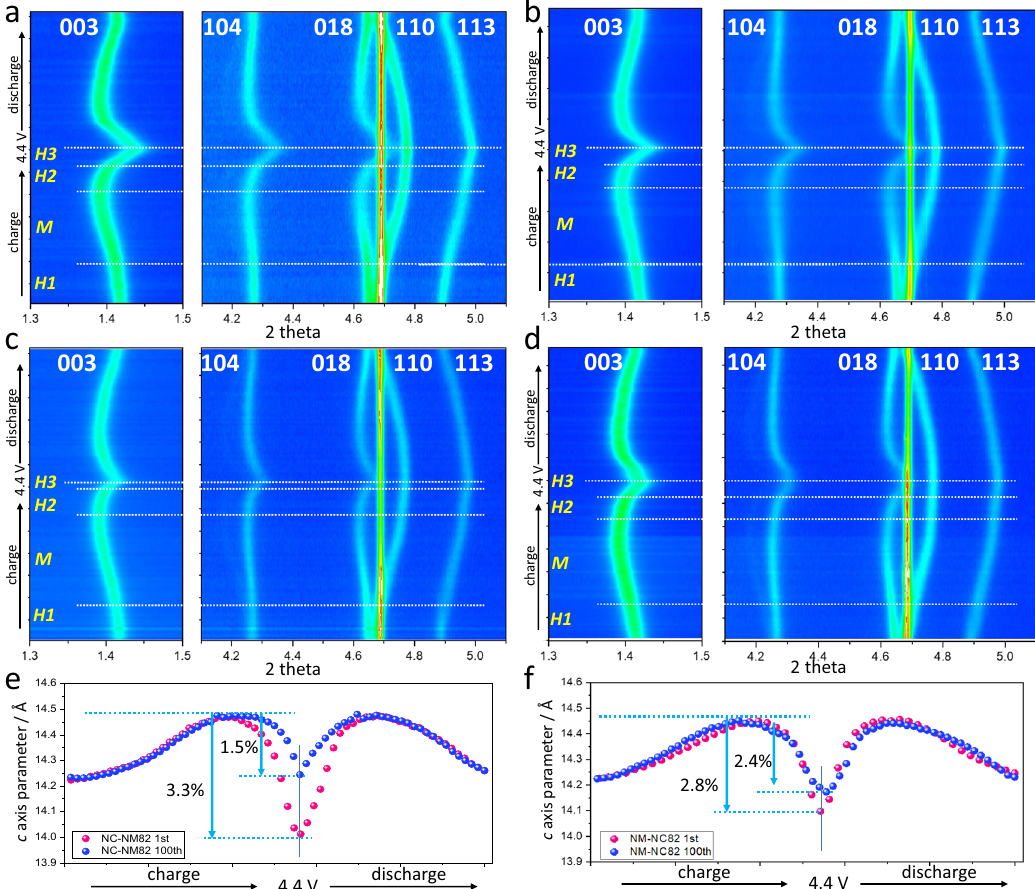
Fig. 5 In situ synchrotron HEXRD characterization during the fi rst cycle and the 101th cycle. a , b Two-dimensional (2D) contour plots of in situ XRD for the structural evolution of NC-NM82 and NM-NC82 during the initial cycle. c , d 2D contour plots of in situ XRD for the structural evolution of NC-NM82 and NM-NC82 during the 101th cycle. These cells were cycled in the voltage range of 2.8 – 4.4 V using a current rate of C/10 (1C = 200 mA g − 1 ). e The c - axis lattice parameter changes of NC-NM82 and NC-NM82 during the initial cycle and the 101th cycle obtained from Rietveld re fi nements. f The c -axis lattice parameter changes in pristine NM-NC82 and NM-NC82 after 100 cycles obtained from Rietveld re fi